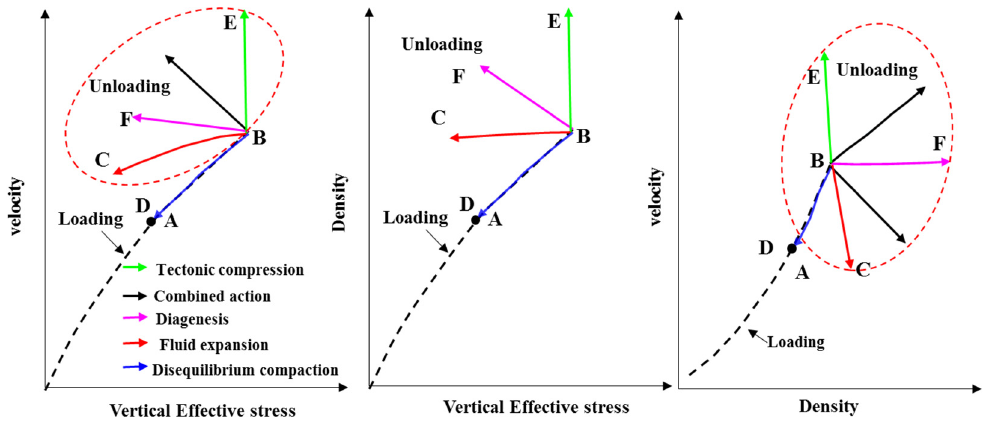
Figure 5. Cross-plots of effective vertical stress vs. acoustic velocity/density and velocity vs. density for the different origins of overpressure.